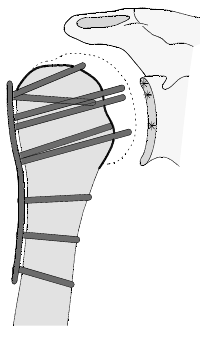
Figure 21. Complication Type 4b. Sample image. Humeral head necrosis after angular stable plate osteosynthesis is illustrated by the transition of the dashed drawing (regular humeral head anatomy) to the inhomogeneous, prominent black drawing. A multiple screw cutout results. The damage to the glenoid articular surface based on this is marked by the star symbols on the cavitas glenoidalis. Table 1 shows an overview of all complication types with sample X-rays and pat- tern